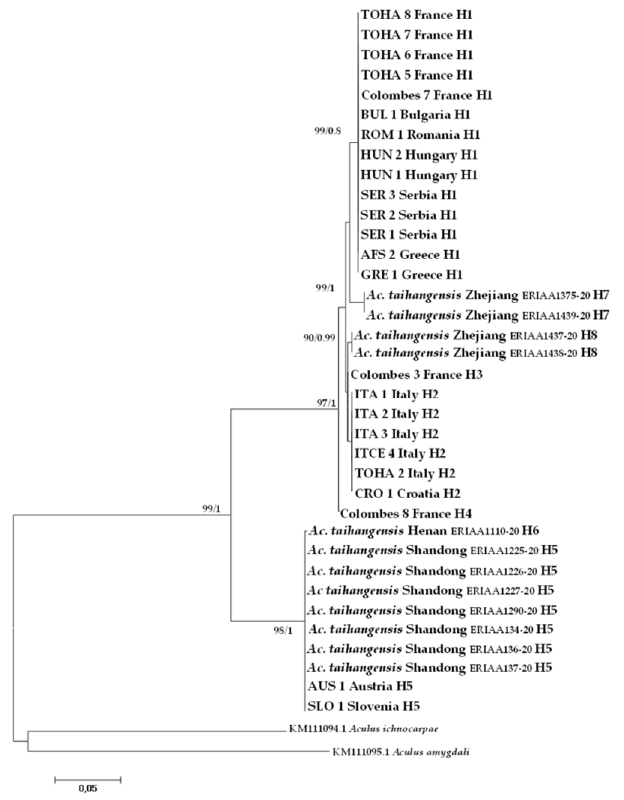
Figure 5. Maximum likelihood phylogenetic tree of CO1 sequences of Aculus mosoniensis , Aculops taihangensis, and two congeners, Aculus ichnocarpae and Aculus amygdali, used as outgroups. Only significant values of bootstrap support (>90%) and of Bayesian posterior probabilities obtained by MrBayes (>0.8) are shown at the nodes. Branch lengths represent expected substitutions per site. The scale bar indicates the expected number of substitutions per site. Tip labels refer to specimen IDs and haplotypes listed in Table 1. Table 2. CO1 pairwise distance matrix with uncorrected p distances shown as percentages (above the diagonal) and K2P distances (under the diagonal) between Aculus mosoniensis , Aculops taihangensis, and two congeners ( Aculus ichnocarpae and Aculus amygdali ), and within Aculus mosoniensis , and Aculops taihangensis (in the diagonal). Data are expressed as mean in % ± S.E. Aculops taihangensis n = 12